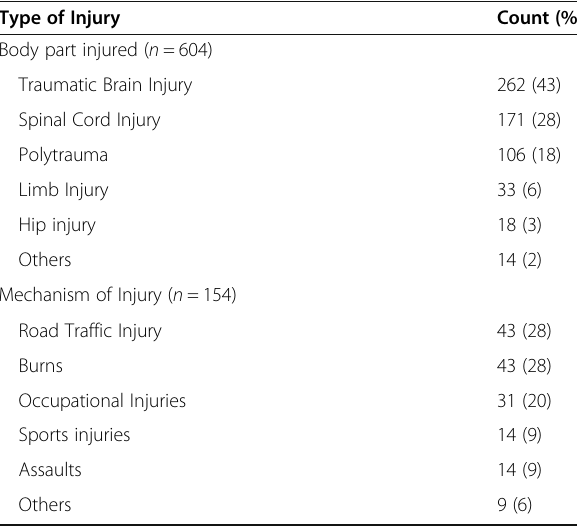
Table 2 Types and Mechanisms of Injury in the Included